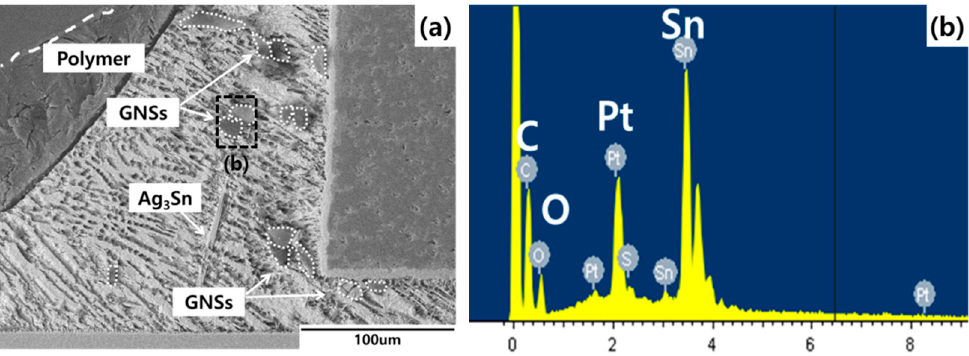
Figure 3. Dispersion of graphene nano-sheets(GNSs) in the solder joints: ( a ) cross-section image of a GNS epoxy solder joint and ( b ) EDS analysis results.